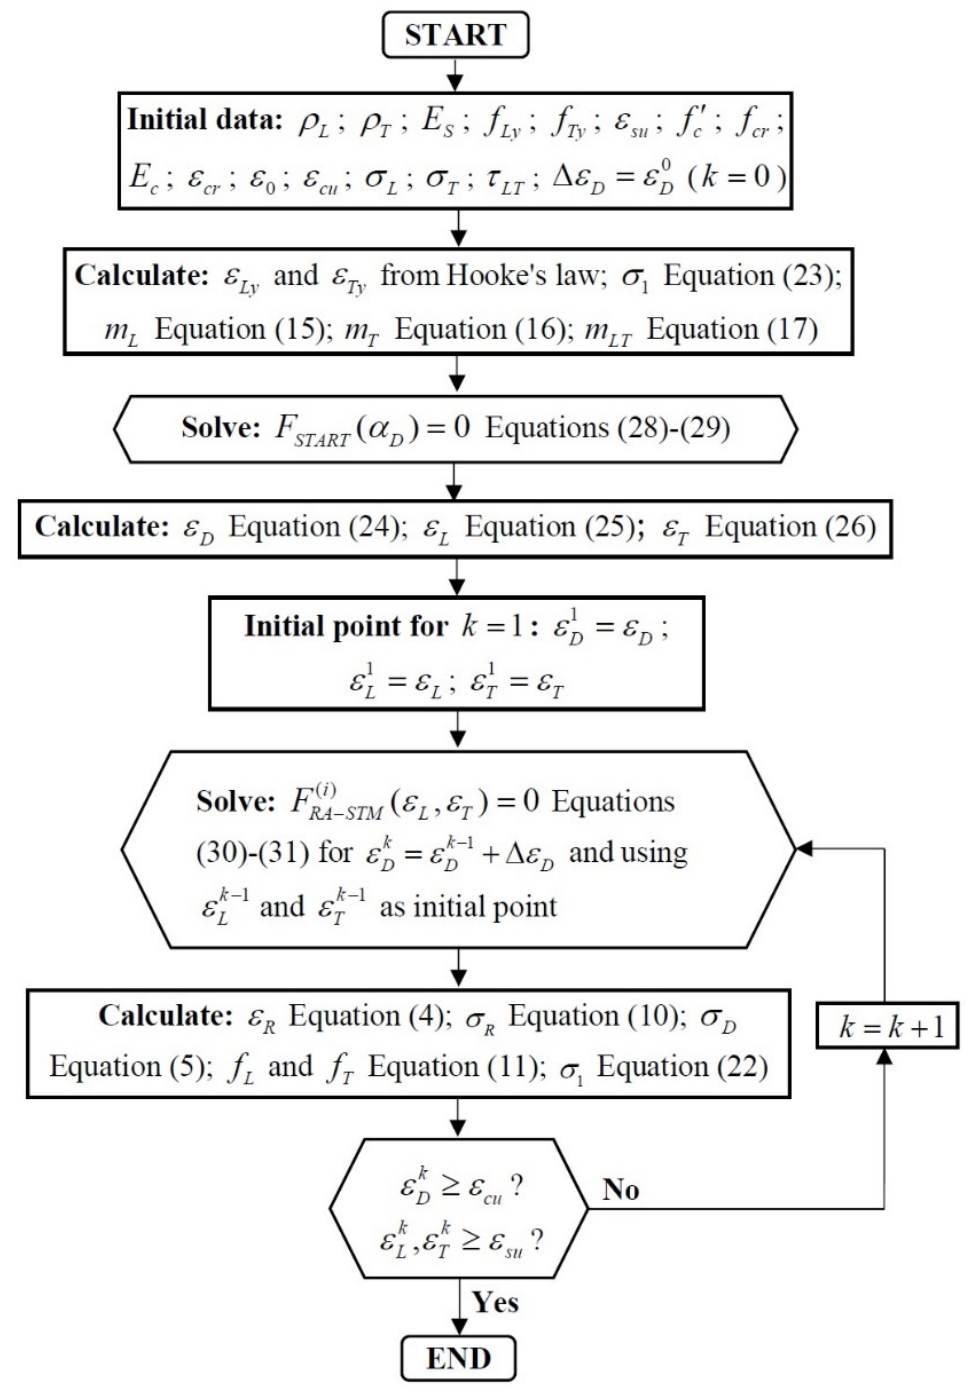
Figure 4. Flowchart. Figure 4.